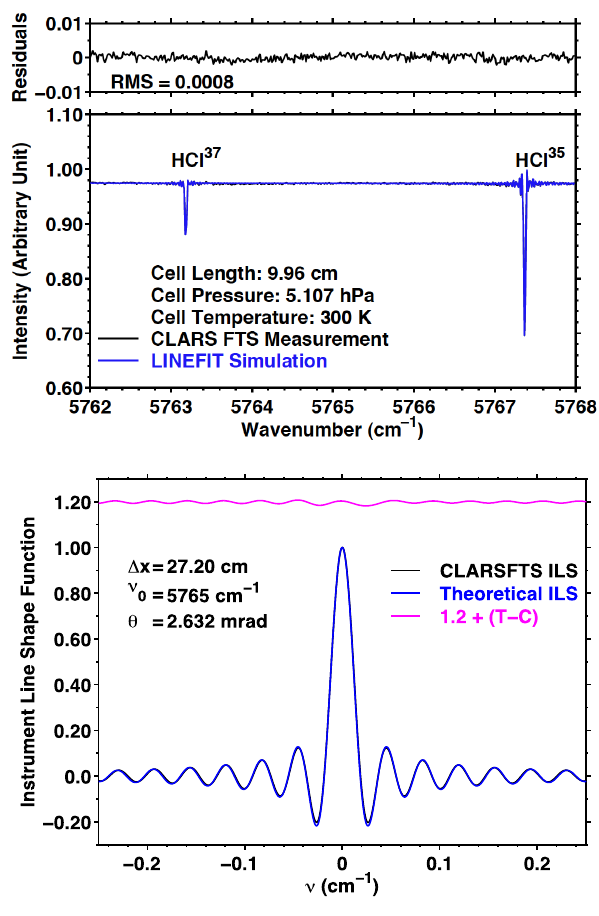
Figure 2 . Top panel: HCl gas cell spectra near 5765 cm -1 measured by CLARS-FTS (black curve) and simulated by LINEFIT program (blue curve); Bottom panel: instrument line shape functions (ILS) of CLARS-FTS (black line) and an ideal FTS (blue line); the differences between theoretical ILS and CLARS-FTS ILS (magenta line; it was offset by 1.2 for clarity). The spectral fitting residuals (top panel) were normalized by the continuum level of measured HCl cell spectra. The root mean square of spectral fitting residual was 0.08% of spectral continuum level. The following parameters were used in both measurements and simulation: an optical path difference = 27.2 cm, an angular radius of the circular internal field of view = 2.632 mrad, HCl cell length = 9.96 cm, gas cell total pressure = 5.107 hPa, HCl gas pressure in the cell = 5.107 hPa, cell temperature = 300 K. The symmetric ILS indicated the high quality of CLARS-FTS alignment. The full width half maximum (FWHM) of CLARS-FTS ILS is 0.022 cm -1 .